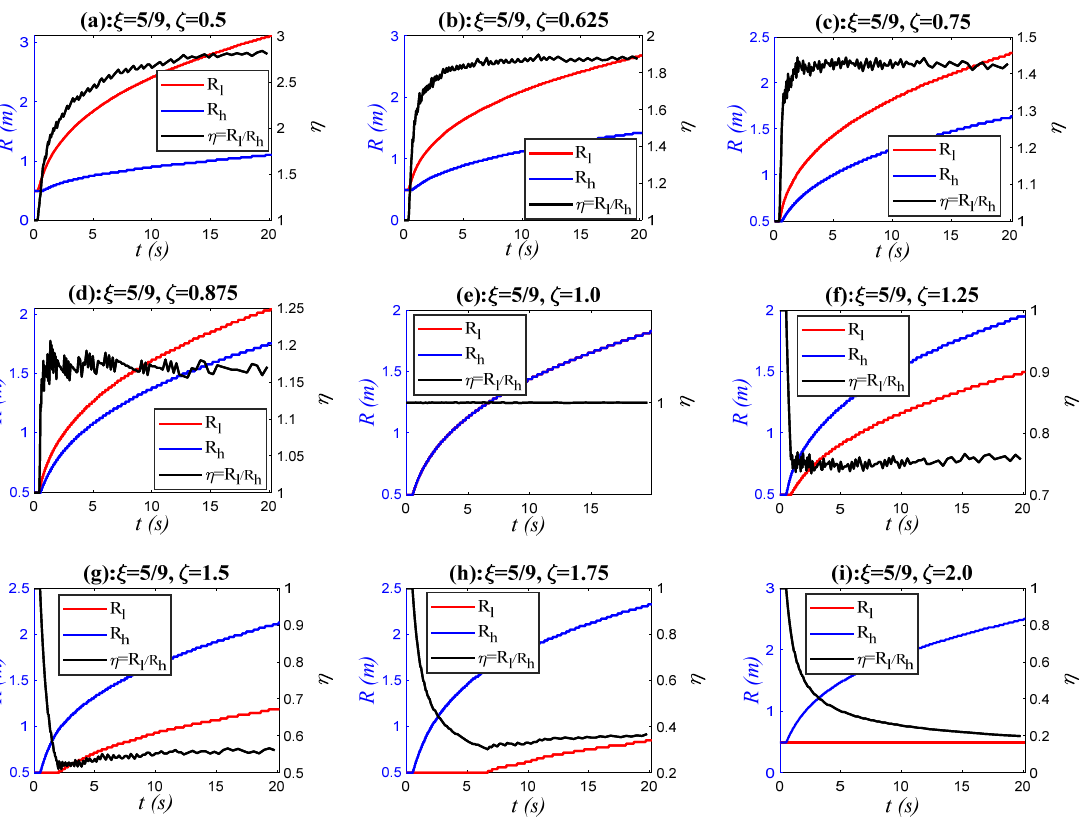
Figure 21. Relationships of the fracture “half-length” ( R l ), “half-height” ( R h ) and the fracture shape coefficient η with respect to time for Group 3 experiments with ξ = 5/9.